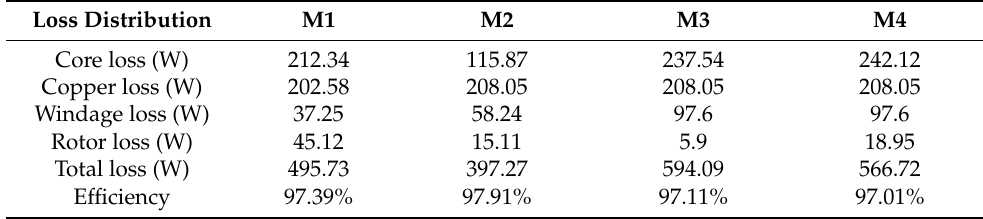
Table 3. Loss distribution of HSPMSMs with different rotors.